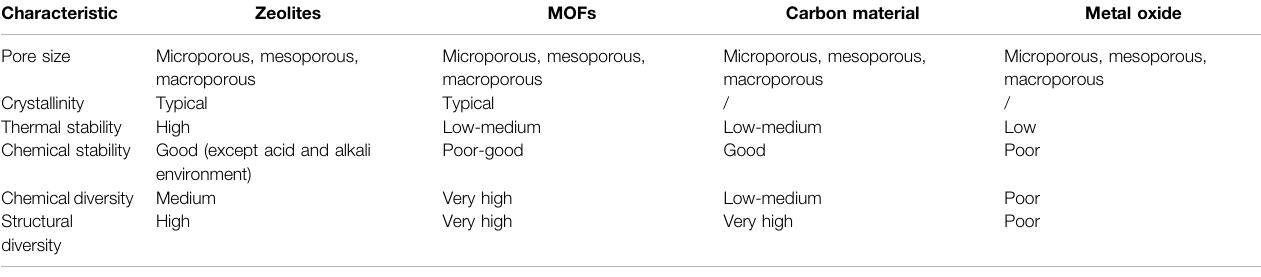
TABLE 3 | Comparison of the performance of two common porous materials.